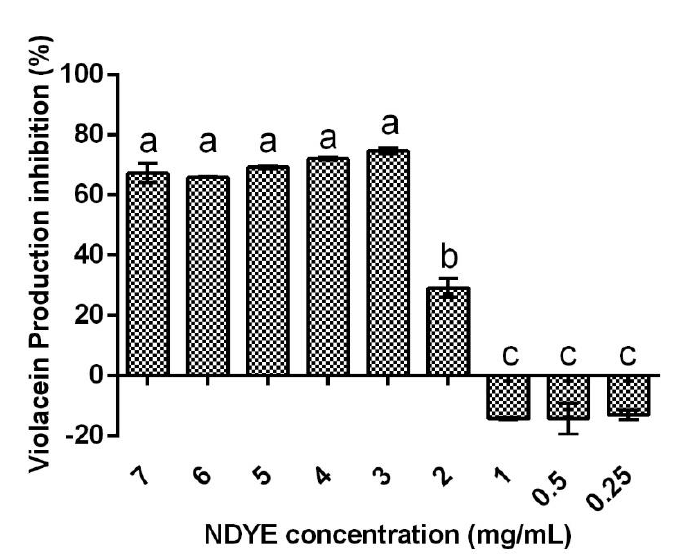
Figure 5. Effect of the tested NDYE concentrations upon the C. violaceum quorum sensing reporter system. Results are given in terms of violacein production inhibition percentages. Different letters represent statistically significant differences found ( p < 0.05).